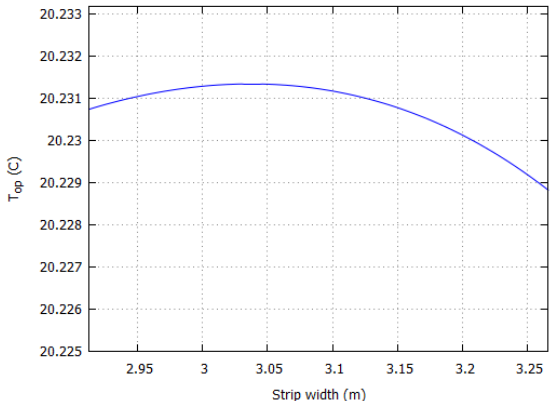
Figure 17. Operative temperature maximum for a strip heated area